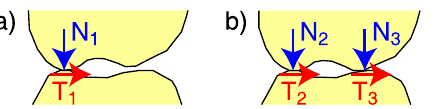
Figure 9. ( a ) One grain contact and ( b ) two grain